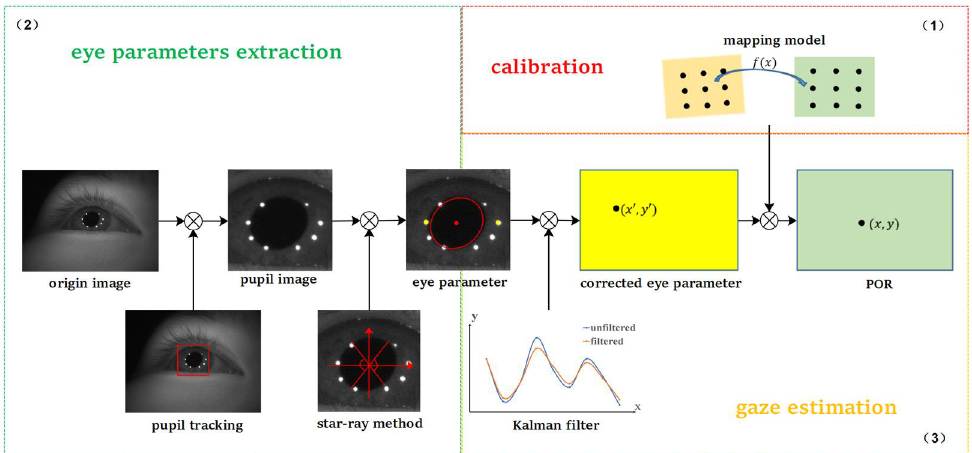
Figure 1. Flowchart of the proposed algorithm. ( 1 ) Schematic diagram of gaze tracking system calibration. ( 2 ) The process of eye parameters extraction. ( 3 ) The process of gaze estimation. Eye parameter extraction (in the green dashed box) refers to the process of obtaining eye parameters from original images, such as the pupil center coordinate and the inclina- tion angle of the fitting ellipse. Eye-parameter extraction is generally performed by first detecting the eye region image, and then extracting the eye parameters. Compared to the conventional method, we introduced two alterations. One alteration is to extract the image near the pupil using a tracking method, instead of extracting the image near the eye using a detection method. The other is to fit the pupil ellipse with the edge points on the left and right sides of the pupil, instead of all edge points. Based on the high speed of tracking, we adopted a tracking method to extract smaller pupil images. For 2D gaze estimation, we need the coordinates of the pupil center; hence, it is perfectly possible to directly construct